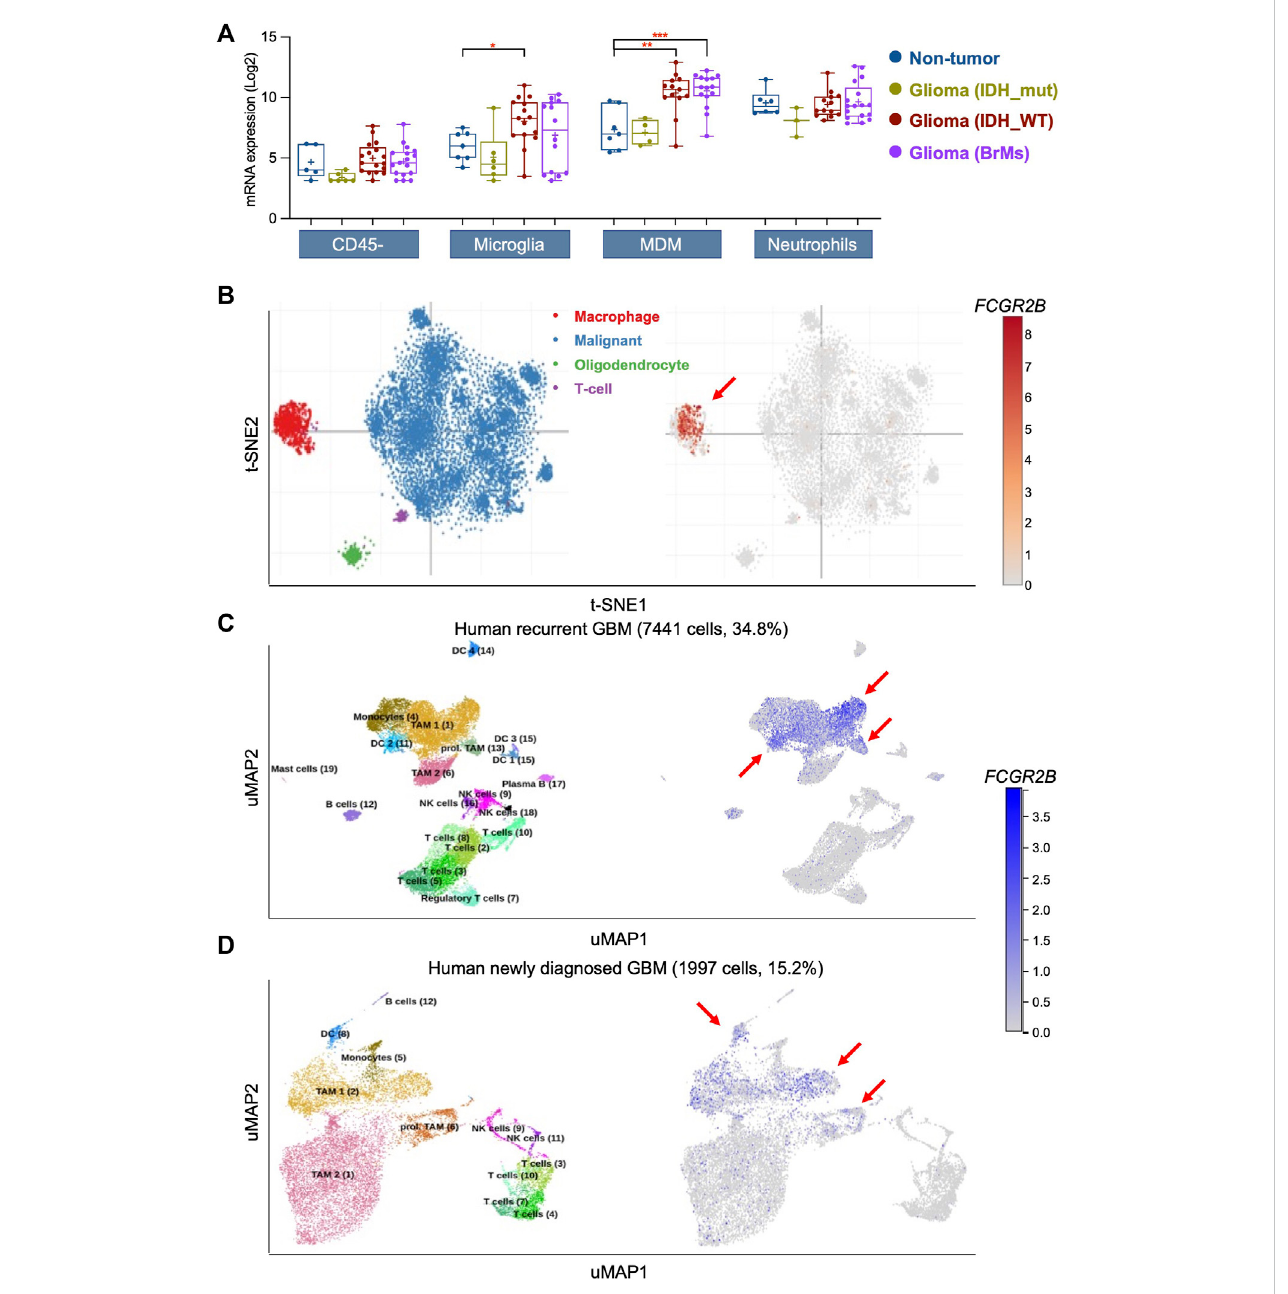
FIGURE 5 Fc γ RIIb is mostly expressed in macrophages and dendritic cells in GBM. (A) Box plots showing the mRNA expression of FCGR2B in CD45 - tumor cells, microglia, monocyte-derivedmacrophages (MDM), and neutrophils in non-tumor, IDH mutant (IDH_mut) type glioma, IDH wild-type (IDH_WT) type glioma, and brain metastases (BrMs) of glioma tissues. * p < 0.05, ** p < 0.01, *** p < 0.001. (B) The t-distributed stochastic neighbor embedding (t-SNE) clustering of single cells with GBM tissues showing the mRNA expression of FCGR2B . Red arrow, main cluster for FCGR2B -expressing cells. (C , D) Uniform Manifold Approximation and Projection (UMAP) clustering of single cells with human recurrent GBM (C) and human newly diagnosed GBM (D) showing the mRNA expression of FCGR2B . Red arrow, main cluster for FCGR2B -expressing